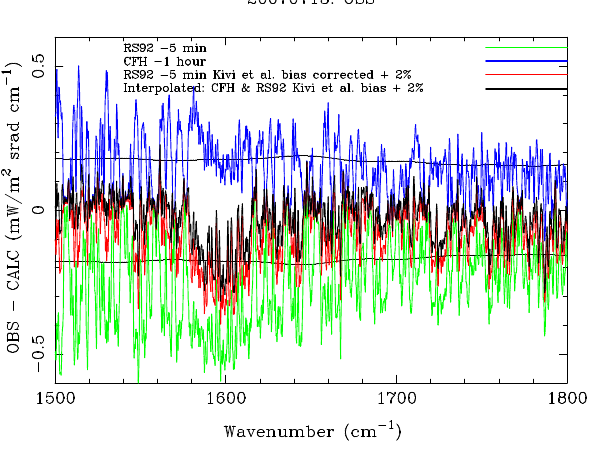
Fig. 8. Residual radiances, IASI observed minus calculated with OSS RTM, for different atmospheric profiles: CFH sonde launched 1h before overpass (blue), RS92 sonde launched 5min before over- pass (green), same sonde but with the “Kivi et al. +2” bias cor- rection (red) and the time interpolated profile (black) using CFH (launched 1h before overpass) and Kivi et al. +2 bias corrected RS92 (launched 5min before overpass) measurements. Thin black nearly flat lines correspond to three sigma IASI instrument noise.